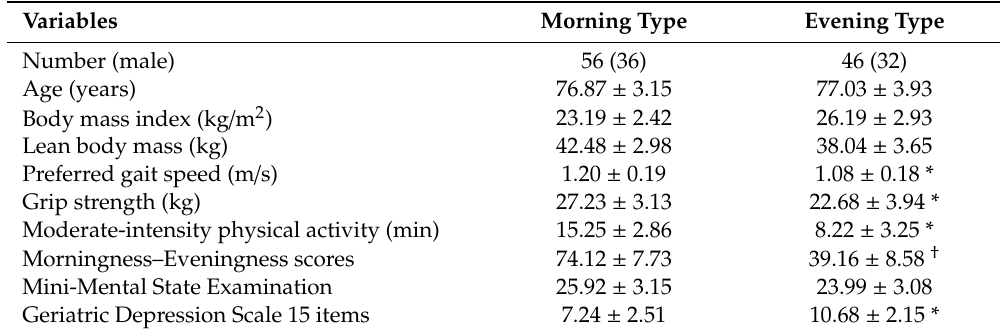
Table 3. Physical and mental function by morningness–eveningness